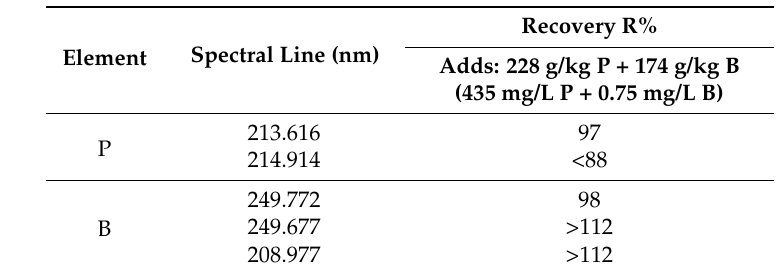
Table 9. Recovery